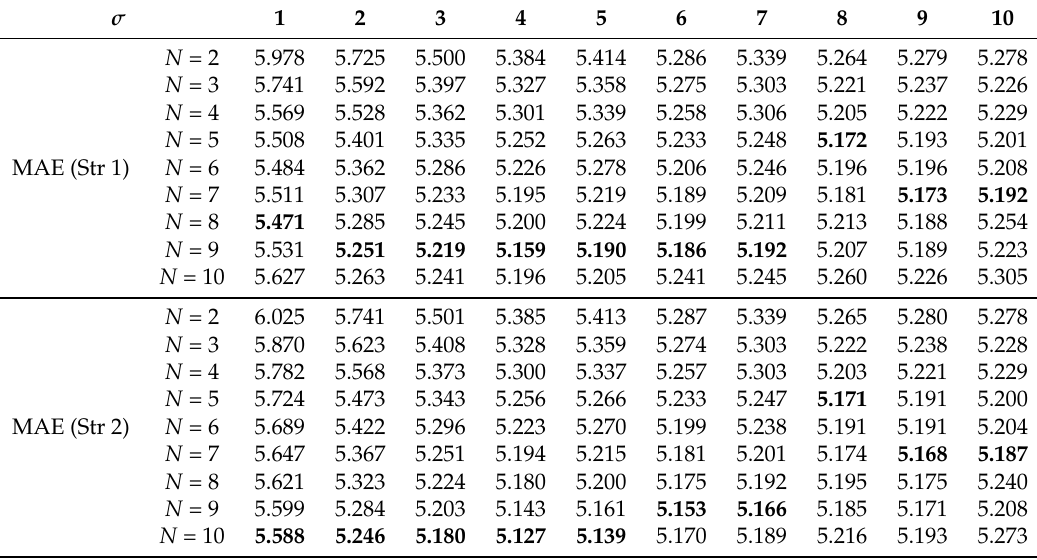
Table 6. The impacts of different values of N (2–10) on MAEs using the proposed SDM-LDL algorithms with Strategies 1 and 2 when age label distribution is generated as Gaussian-like ( σ from one to 10; for every σ , the optimal MAEs are marked in